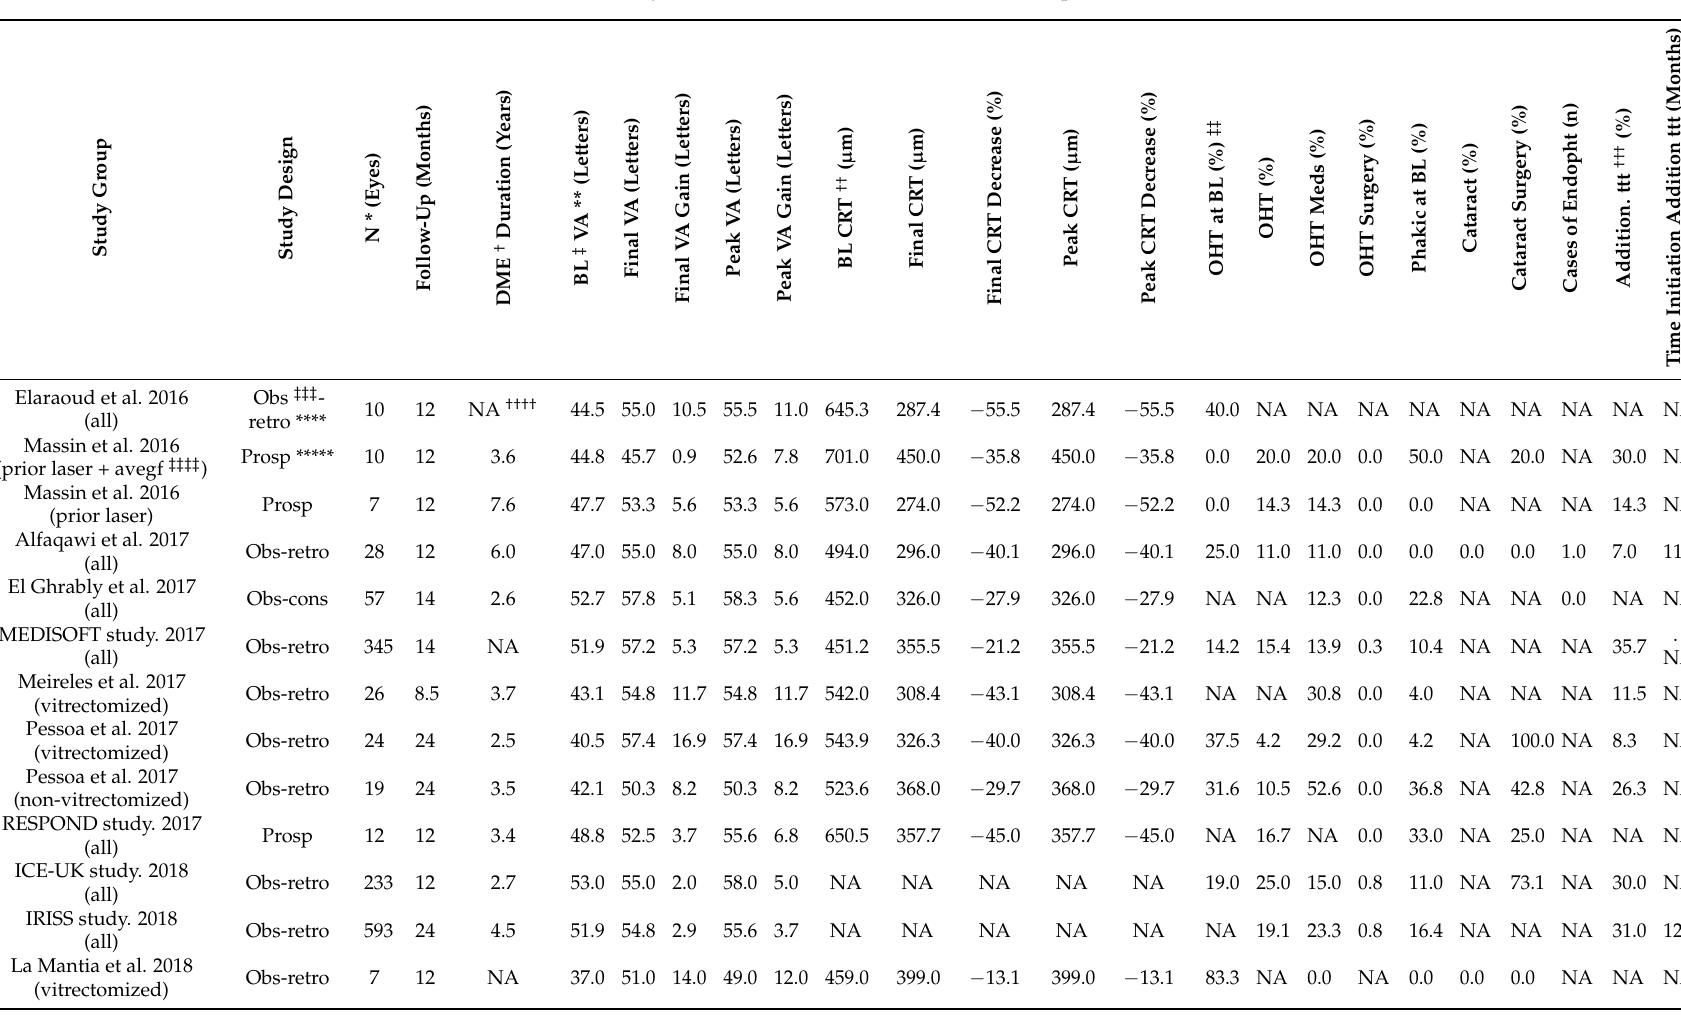
Table 1. Summary of real-world fluocinolone acetonide implant